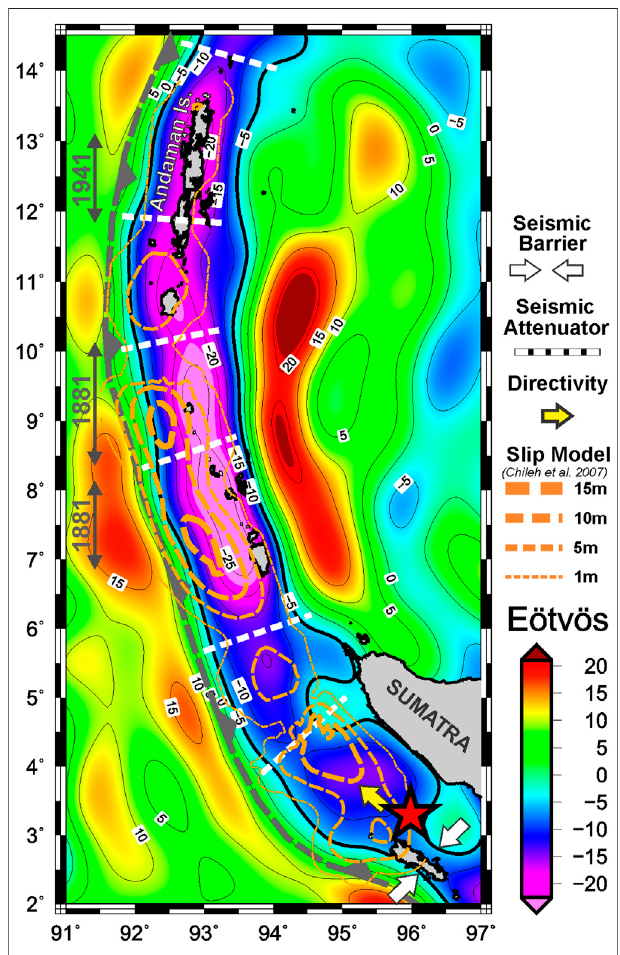
FIGURE 5 | Slip model for the Mw (cid:1) 9.15 2004 Sumatra-Andaman earthquake (Chlieh et al., 2007) superimposed to the topography corrected Vertical Gravity Gradient (Tzz) obtained from GOCE model GO_CONS_GCF_2_DIR_R6 up to N (cid:1) 200 (Bruinsma et al., 2014). The dashed white line indicates the location of regions that behaved as seismic energy attenuators; white arrows indicate the existence of a seismic barrier that arrested rupture propagation. Historical great earthquakes are indicated with gray